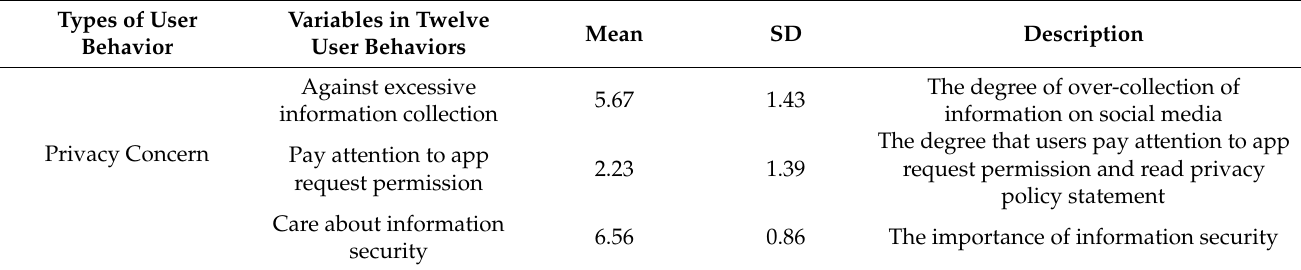
Table 1. Descriptive statistics for twelve